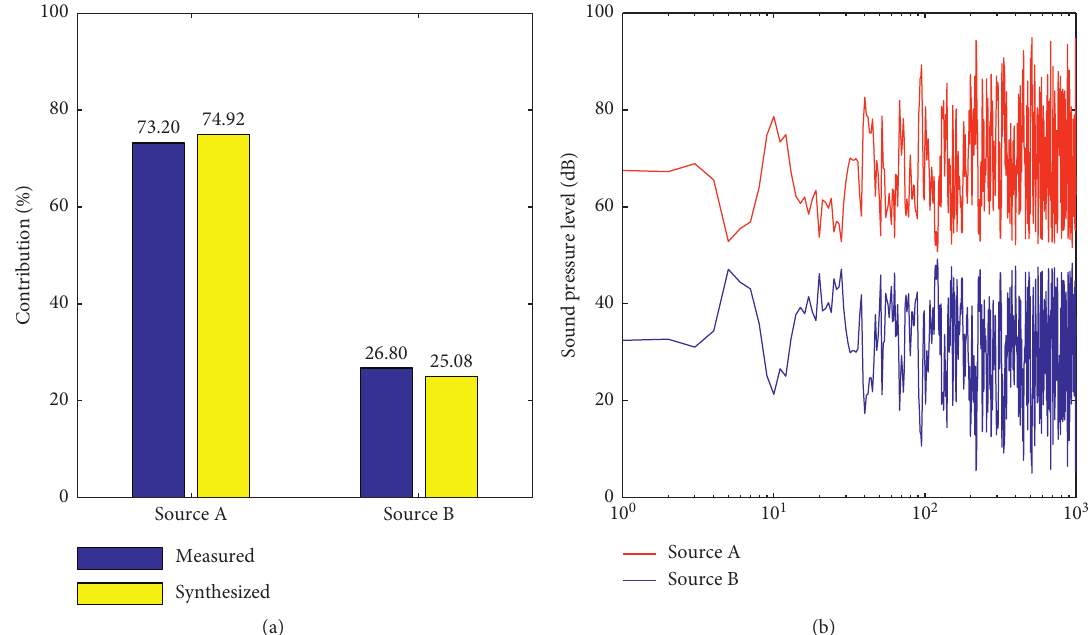
Figure 12: Contribution percentages of both sources with the proposed OTPA: (a) overall contribution; (b) point by point contribution.